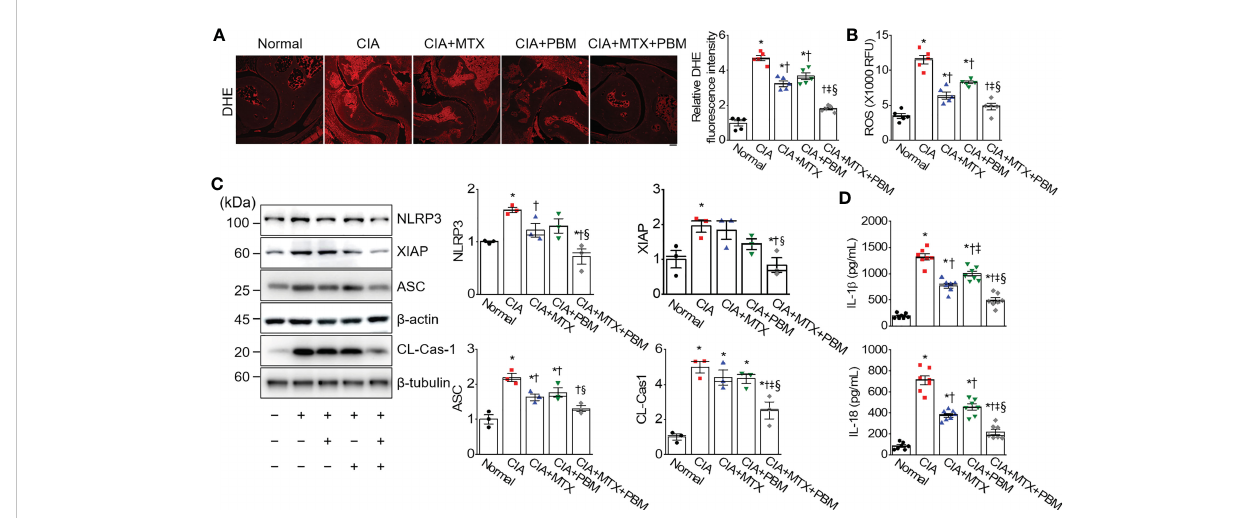
FIGURE 5 PBM inhibites ROS-mediated in fl ammasome activation in CIA mice. (A) Superoxide [dihydroethidium (DHE)] staining in ankle joints tissue. Scale bar, 100 m m. Bar graphs represent the quanti fi cation of DHE fl uorescence intensity. (B) ROS level. RFU represents relative fl uorescence units ( n = 5). (C) Detection of pyroptosis signals ( n = 3). (D) Measurement of IL-1 b and IL-18 in ankle joints tissue lysates ( n = 7). Data are shown as mean ± SE. * p < 0.05, compared to Normal. † p < 0.05, compared to CIA. ‡ p < 0.05, compared to CIA+MTX. § p < 0.05, compared to